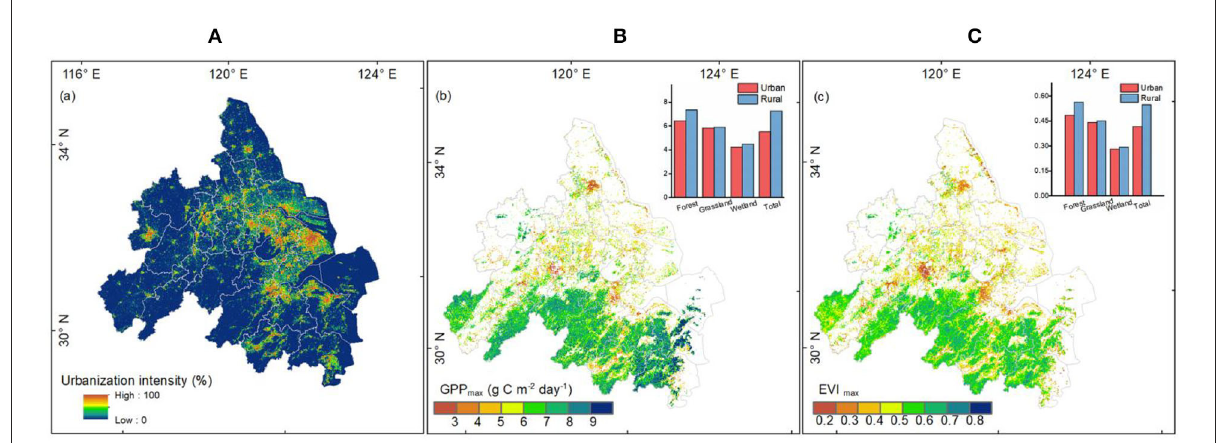
FIGURE2 The spatial patterns of (A) urbanization intensity, (B) GPP max , and (C) EVI max in YRDUA in 2020. The small map at the corner compares GPP max and EVI max between urban and rural areas for the whole study area and the three main vegetation types.